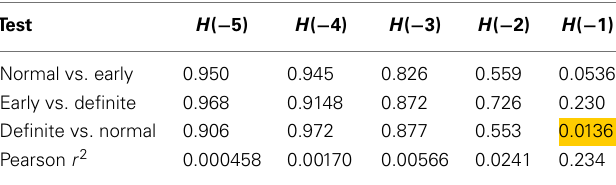
Table 6 | Results of Mann–Whitney tests for Renyi entropy calculated with negative exponents and using method 9 .